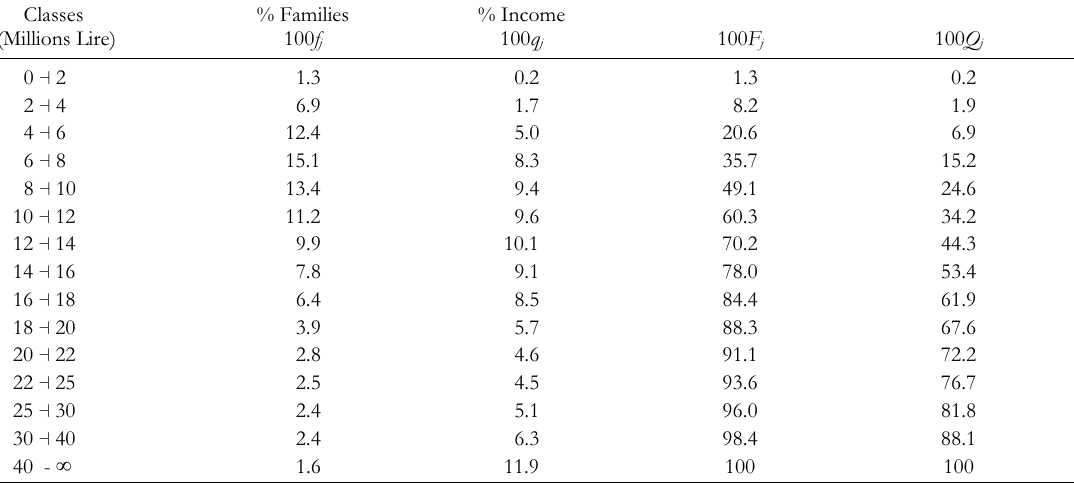
Distribution of 3,000 families in 15 income classes (Banca d’Italia Survey, 1980). (Mean income m = 12.856 millions